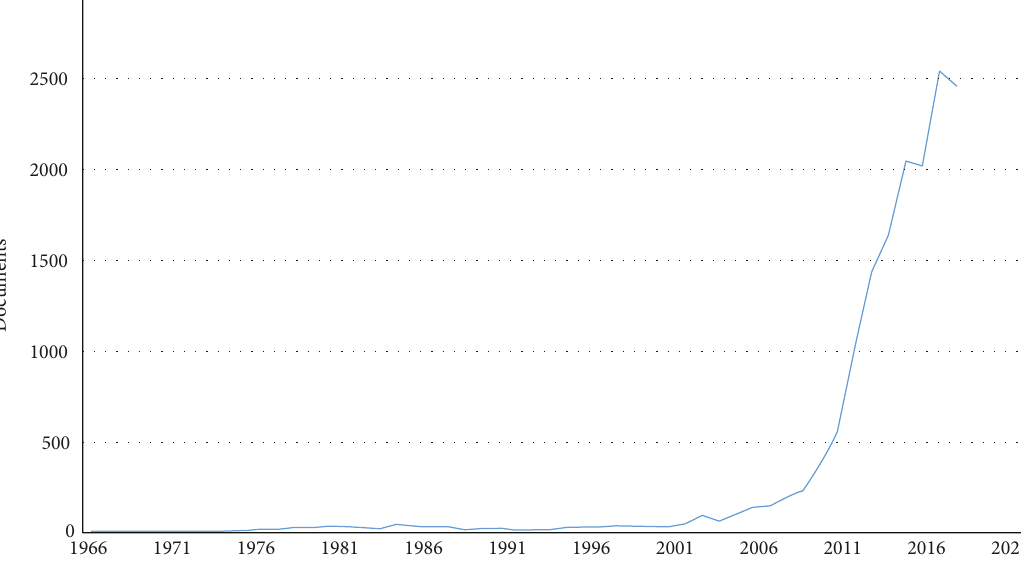
Figure 8: Documents related to microgrid, smart grid, and energy systems simulation in the SCOPUS database until 2017. Table 10: Overview of the most cited documents and top authors related to microgrid and smart grid simulation. Search